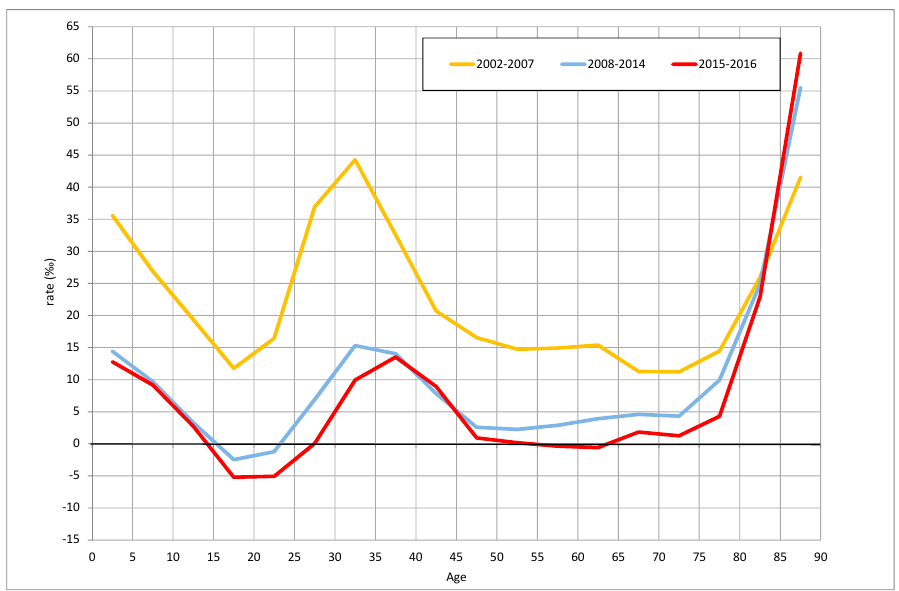
Figure 6. Net intrametropolitan migration rates by age in BMR dispersed municipalities (2002–2016). Source: Compiled by the authors based on data from the Padrón continuo (Continuous Register) 1996–2017 and the Estadística de Variaciones Residenciales (Residential Change Statistics) 1996–2016, microdata file, INE.